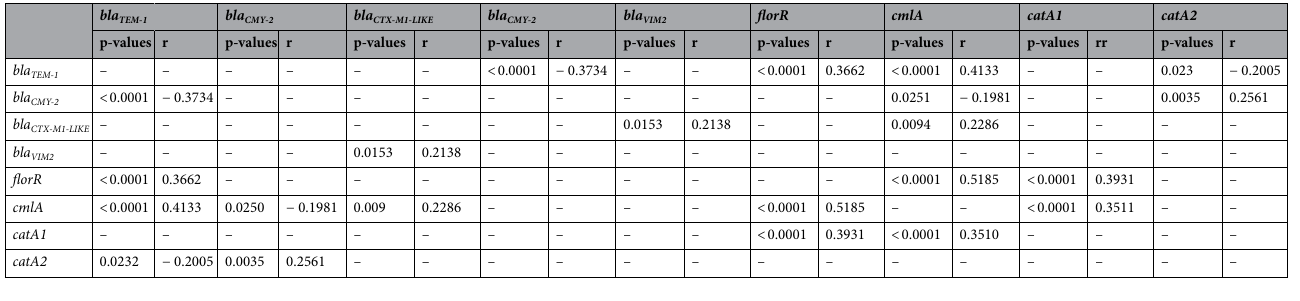
Table 2. Co-occurrence of antimicrobial resistance genes. Spearman’s r and p-values are reported.